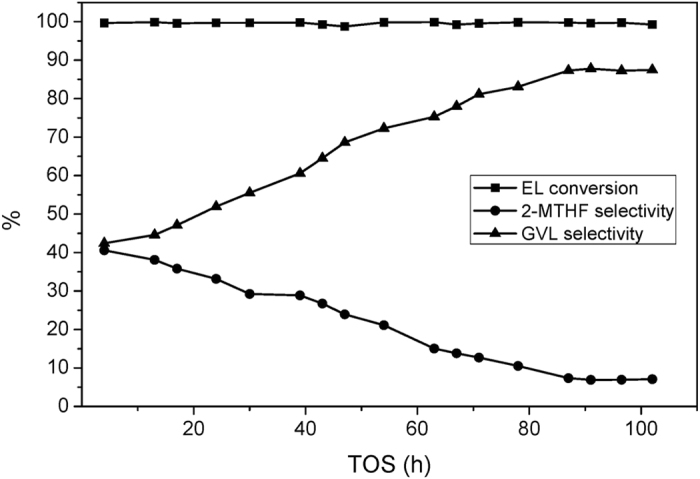
The initial activity of the Cu/Al2O3-SiO2 catalyst on EL hydrogenation.